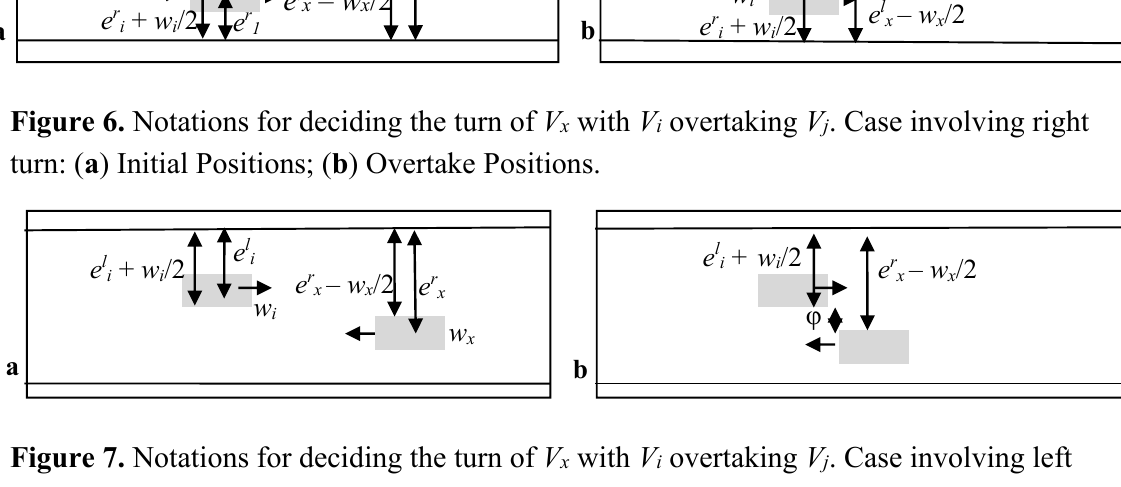
Figure 7. Notations for deciding the turn of V x with V i overtaking V j . Case involving left turn: ( a ) Initial Positions; ( b ) Overtake